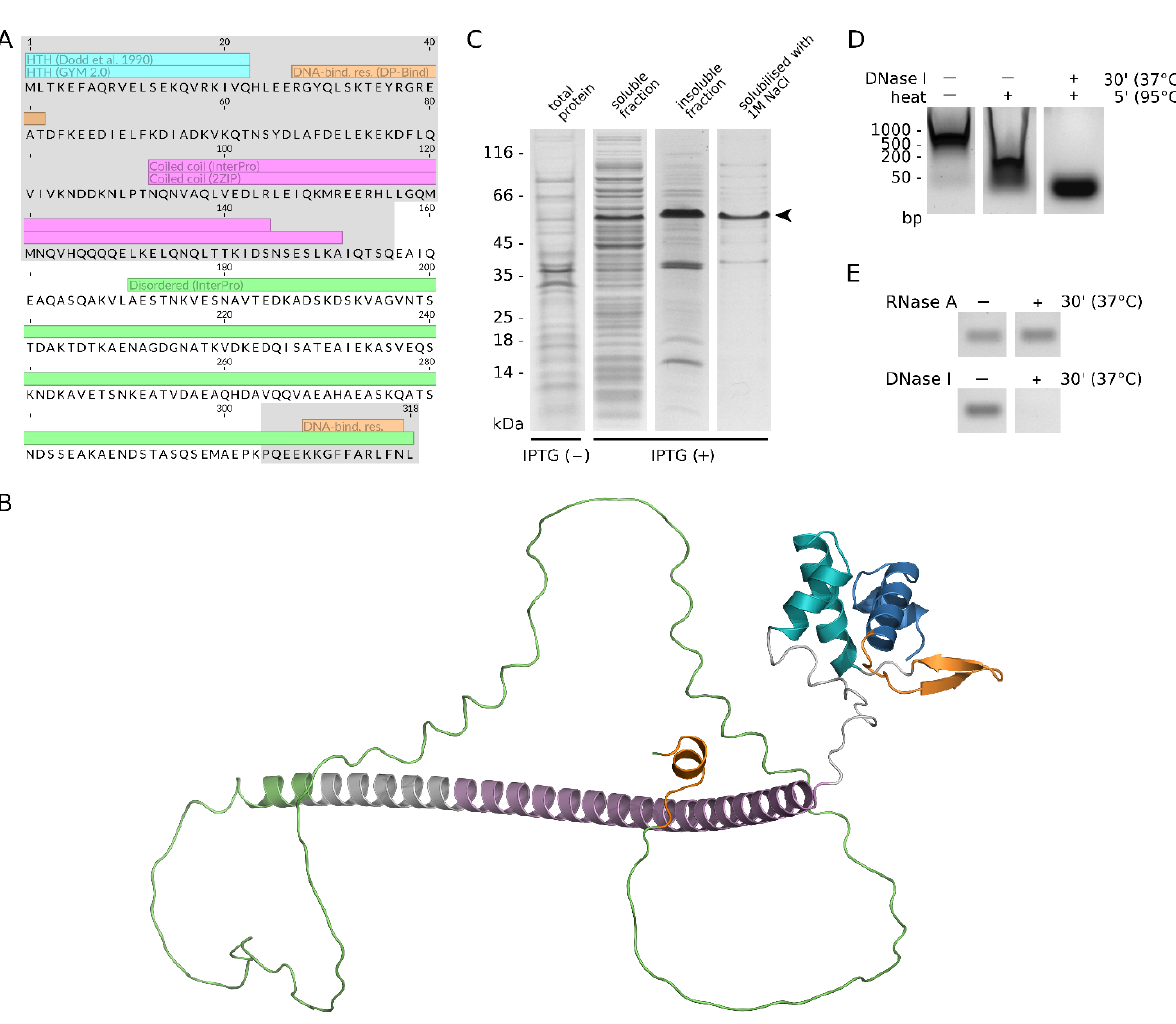
Figure 2. SaoC is a DNA-binding protein. ( A ) In the SaoC sequence from S. aureus it is possible to detect different DNA-binding motifs (HTH, skyblue; coiled coil, magenta) and extents of residues (orange) by using different available tools (GYM 2.0, NPS@ tool based on Dodd and Egan, DP-Bind, 2ZIP, InterPro Scan). Notably, all these motifs are located in the parts of SaoC that are highly conserved among different staphylococcal species, whereas the highly variable SaoC part is predicted to be of unordered structure (green). ( B ) Some of the predictions made by the aforementioned tools align with SaoC structure as modelled by AlphaFold. The N-terminal part starts with a HTH motif (blue), followed by a β -sheet corresponding to predicted DNA-binding residues (orange), and an- other, not predicted before, HTH motif (cyan). The region initially predicted as a coiled coil (ma- genta) is α -helical in the model, which may indicate the possible presence of a coiled coil tertiary structure. Most of the remaining part of SaoC remains unordered, similarly to the initial prediction (green). The C-terminal motif, which was predicted to contain DNA-binding residues (orange), is an exception as it is modelled as a short α -helix. ( C ) SaoC when produced in E. coli exhibits proper- ties typical for DNA-binding proteins. It migrates slower in SDS-PAGE than expected by its molec- ular mass and forms aggregates that may be solubilised with 1 M NaCl. ( D ) The solubilised samples of SaoC contain nucleic acids as evidenced in agarose gel electrophoresis. They might be released from complexes with SaoC by thermal denaturation. If treated with DNAse I beforehand, short frag- ments are protected from digestion. ( E ) The short nucleic acid fragments are degraded by DNAse I but not by RNAse A, which shows they are in fact DNA fragments. SaoC binds to a sequence motif upstream of its own gene . In order to determine factors that may bind the conserved, uncharacterised sequences located upstream of saoC (Figures 1A and 3A), we chose to carry out pull-down assays with different fragments of saoABC operon non-coding sequences (Figure 3A) immobilised on magnetic beads and